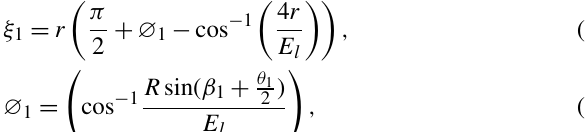
Table 2. The required joint torque in Nmm for each finger. The index The middle The ring The small MCP joint 42.55 43.15 PIP joint 6.35 DIP joint 0.476 0.476